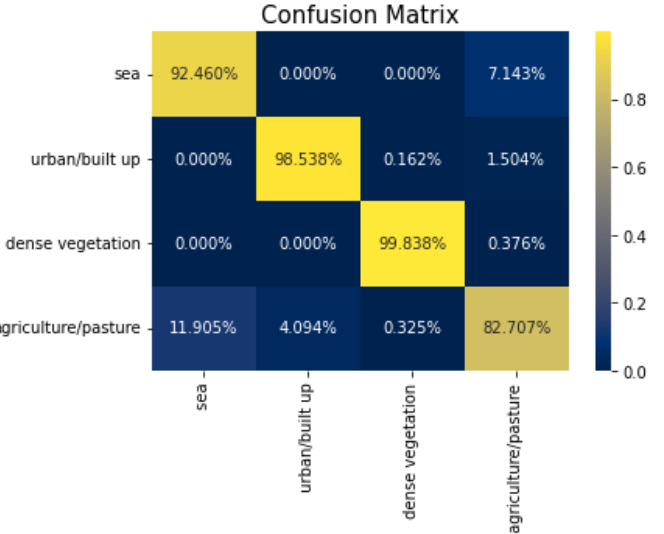
Figure 7. Confusion matrix that visualizes the performance of the proposed system. The true labels are depicted vertically and, horizontally, the predicted labels.